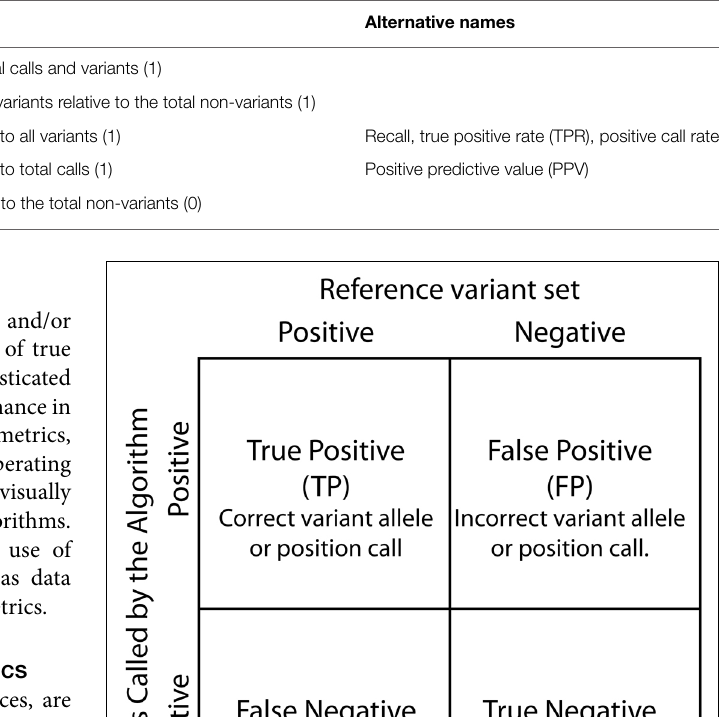
TABLE 1 | Definitions of common performance metrics used in evaluating variant callers.